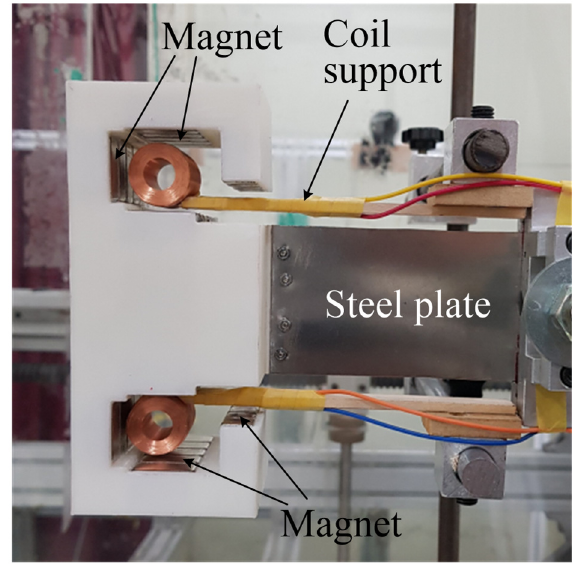
Figure 9. Prototype of the proposed galloping energy harvester with four Halbach arrays. Table 1. Parameters of a single coil.